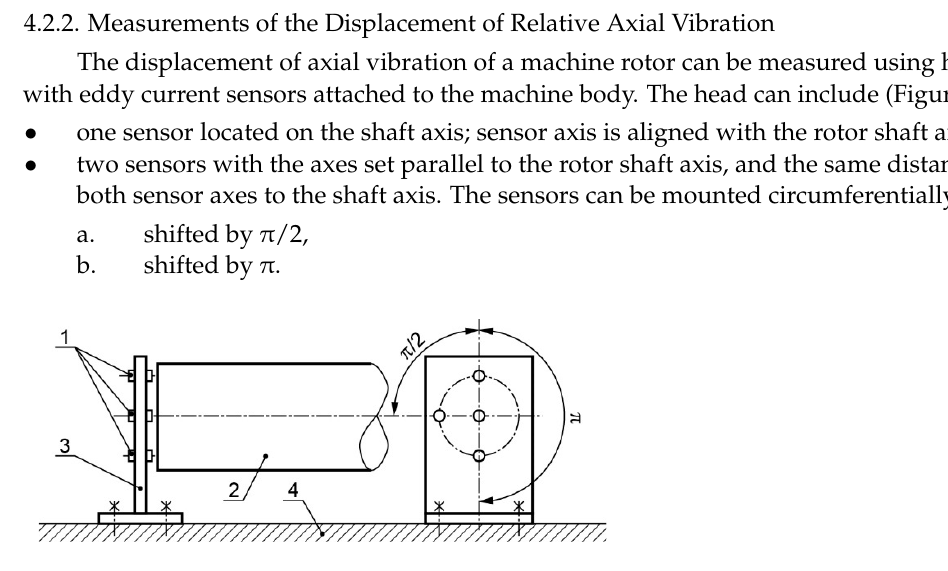
Figure 14. The configuration of sensors of the rotor relative axial vibration: 1—eddy current sensor; 2—rotor shaft; 3—head; 4—machine body.